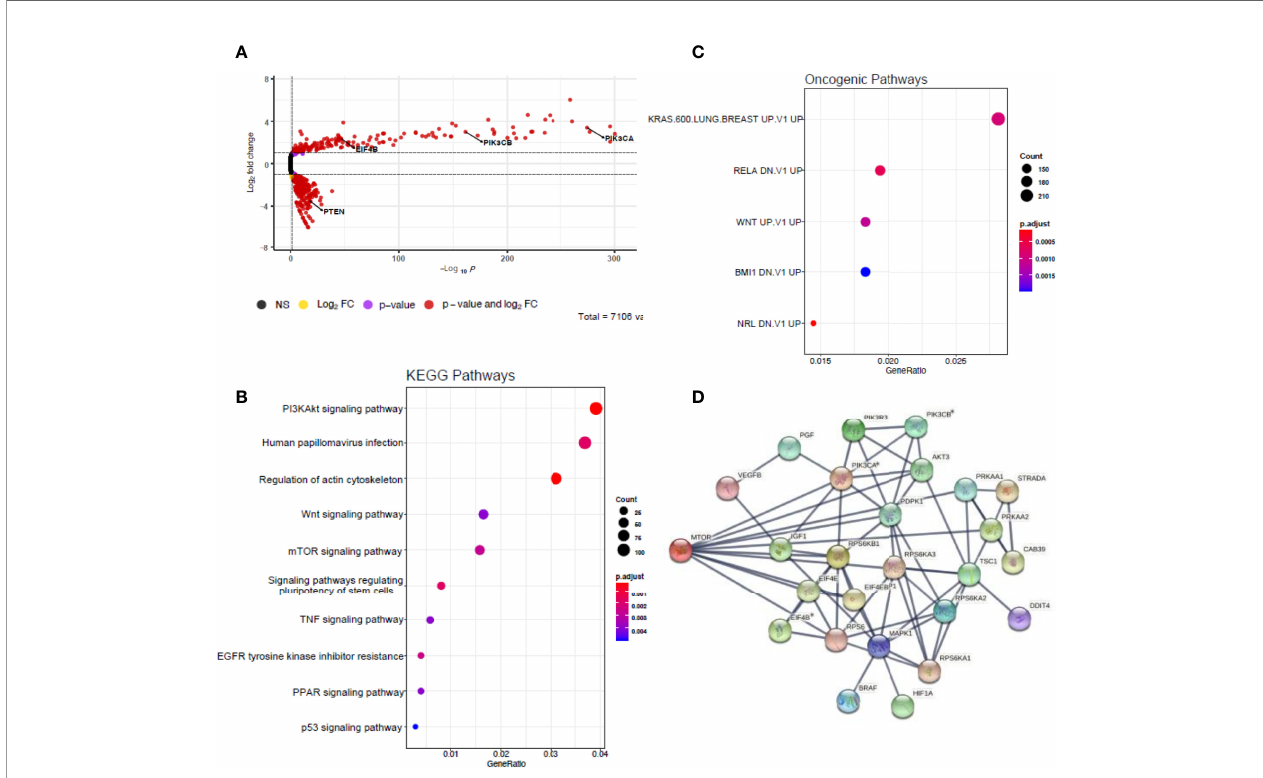
FIGURE 5 | Genome-wide CRISPR screens identify mTOR signalling up-regulates pathway genes. (A) Volcano plot depicting signi fi cantly differentially expressed genes (p < 0.05 and |fold change| > 1) in red. Model-based analysis of genome-wide CRISPR-Cas9 knockout on libraries A and B detected twenty-six expressed genes from mTOR signalling pathway gene list based on molecular signatures database (MSigDB) v7.4. (B) Dot plot showing signi fi cantly over-represented KEGG pathway terms that were de fi ned from MSigDB v7.4 using the 3,207 DEGs with p < 0.05. (C) Dot plot showing signi fi cantly over-represented oncogenic pathway terms that were de fi ned from MSigDB v7.4 using the 3,207 DEGs with p < 0.05. (D) Network diagram representing the mTOR signalling events mediated by PIK3CA, PIK3CB and EIF4B using STRING 2 weighted correlation network analysis (WGCNA). Asterisks represent statistically signi fi cant levels of gene differences between control and irradiated samples (p< 0.05) calculated using Student ’ s t test. NS, non-signi fi cant; FC, fold